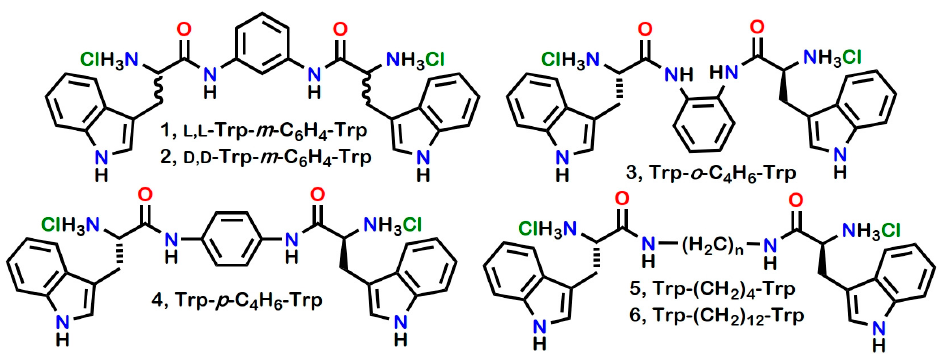
Figure 1. Structures of bis (tryptophan) derivatives 1 – 6 .